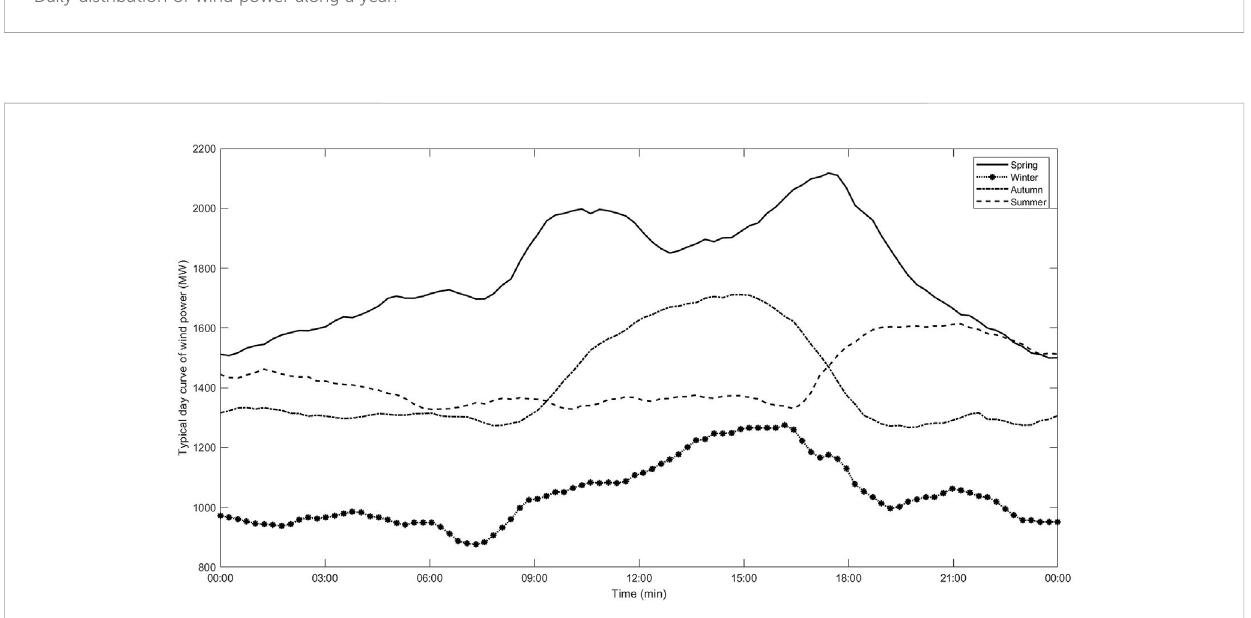
FIGURE 3 The typical curve for each season of wind power.